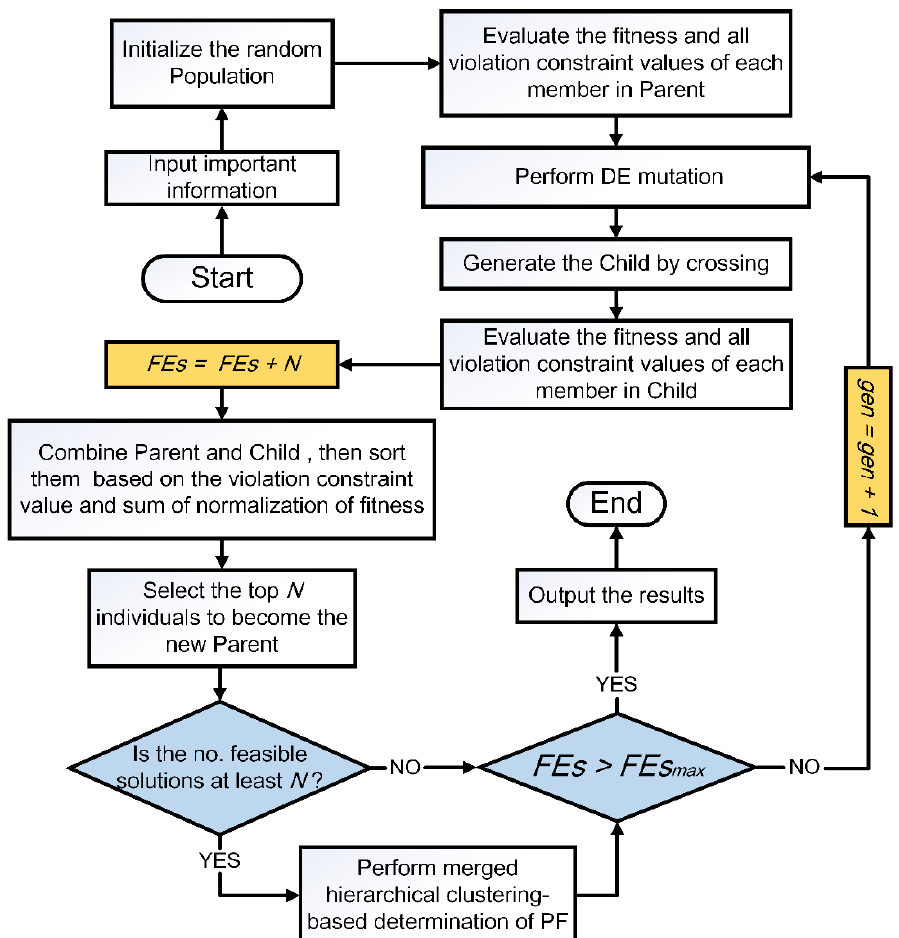
Figure 3. The flowchart of CMODE for the MOOPF problem.